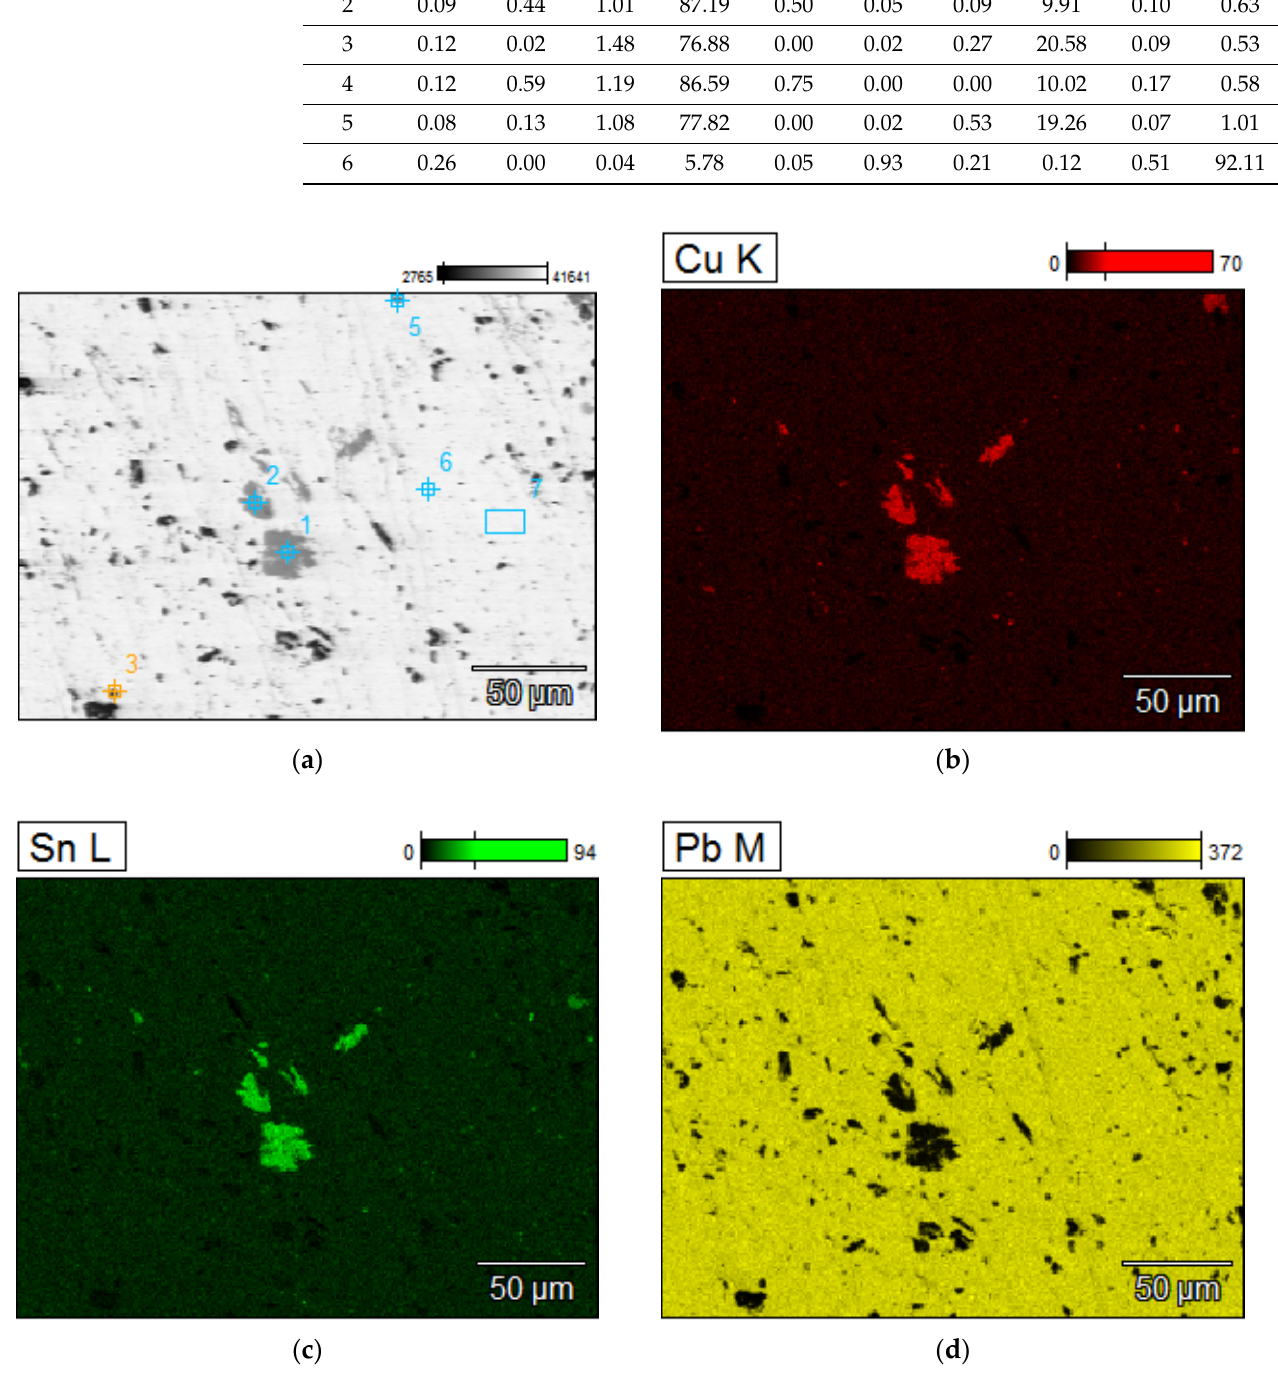
Figure 8. Elements mapping of the lead ingots after melting with PCB pyrolyzate “B3”, m PBC / m Pb = 0.1 g ∙ g − 1 . ( a ) scanning electron microscopy with a points of chemical composition; ( b – d ) copper, tin and lead located in specific areas within the alloy.